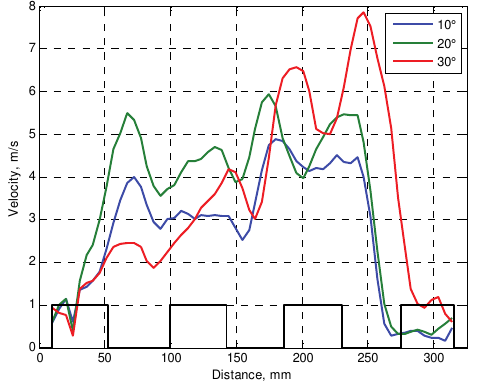
Fig. 14. Air velocity profiles in the manifold outflow plane for different throttle position angles at 1500 RPM